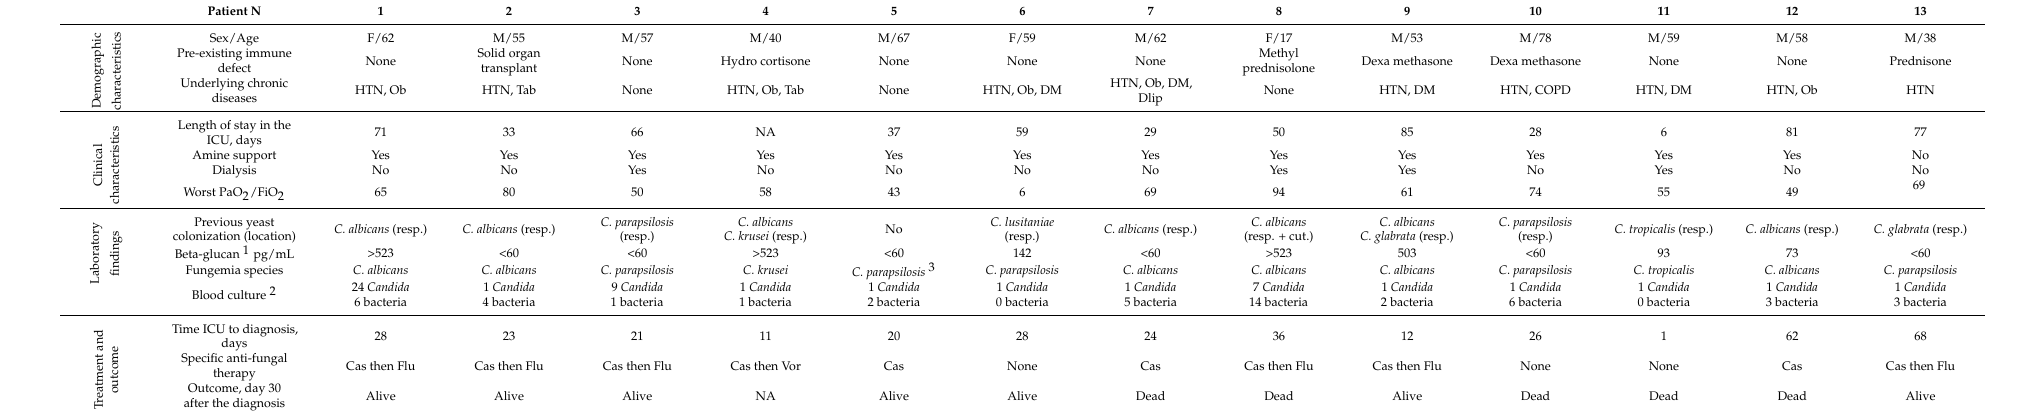
Table 1. Clinical and mycological characteristics of 13 ICU patients with severe COVID-19-related pneumonia.